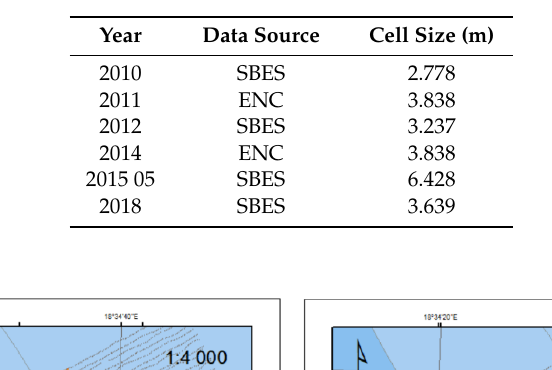
Table 6. Default value of cell size.